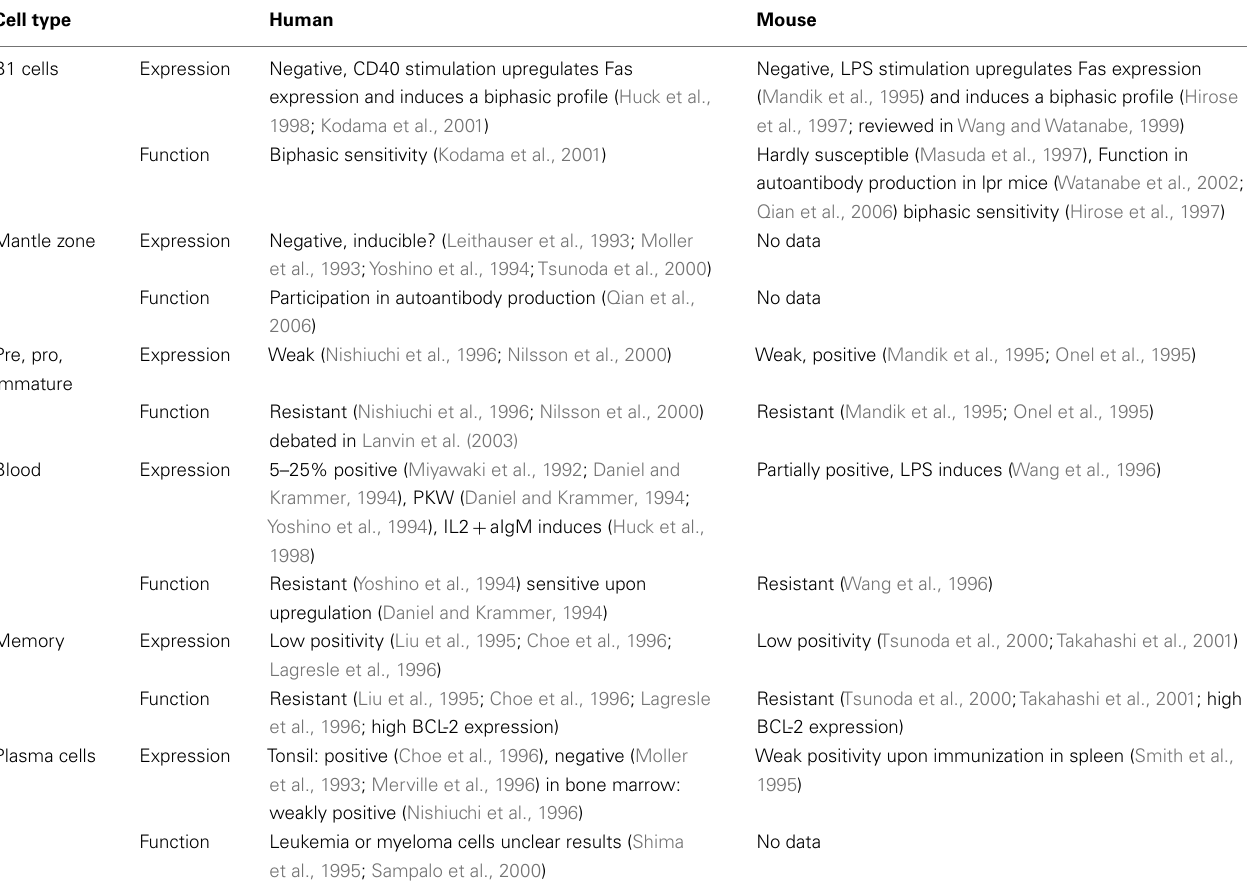
Table 1 | Expression and function of Fas and sensitivity to Fas-induced cell death in different B cell